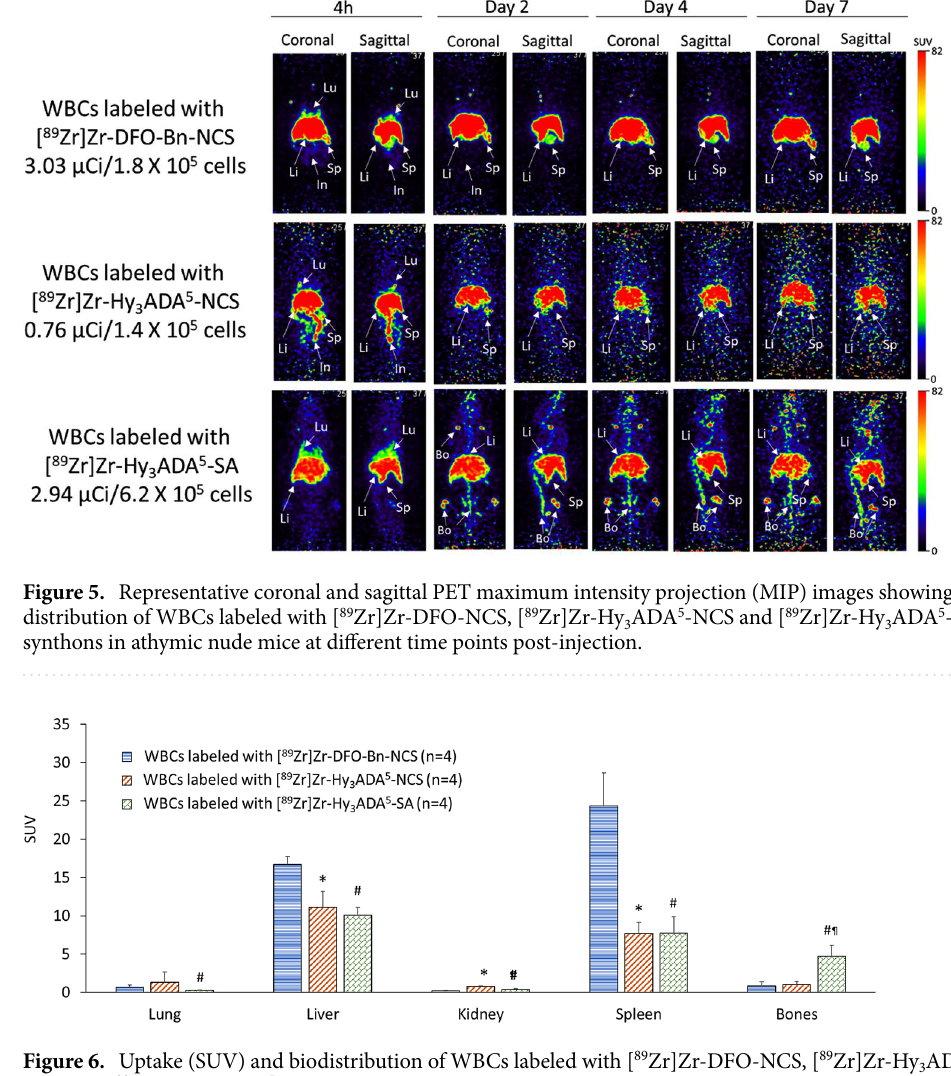
Figure 6. Uptake (SUV) and biodistribution of WBCs labeled with [ 89 Zr]Zr-DFO-NCS, [ 89 Zr]Zr-Hy 3 ADA 5 - NCS and [ 89 Zr]Zr-Hy 3 ADA 5 -SA synthons in major organs of athymic nude mice at day 7 post-injection. *p < 0.05 WBCs labeled with [ 89 Zr]Zr-DFO-Bn-NCS Vs [ 89 Zr]Zr-Hy 3 ADA 5 -NCS; # p < 0.05 WBCs labeled with [ 89 Zr]Zr-DFO-Bn-NCS Vs [ 89 Zr]Zr-Hy 3 ADA 5 -SA and ¶ p < 0.05 WBCs labeled with [ 89 Zr]Zr-Hy 3 ADA 5 -NCS Vs [ 89 Zr]Zr-Hy 3 ADA 5